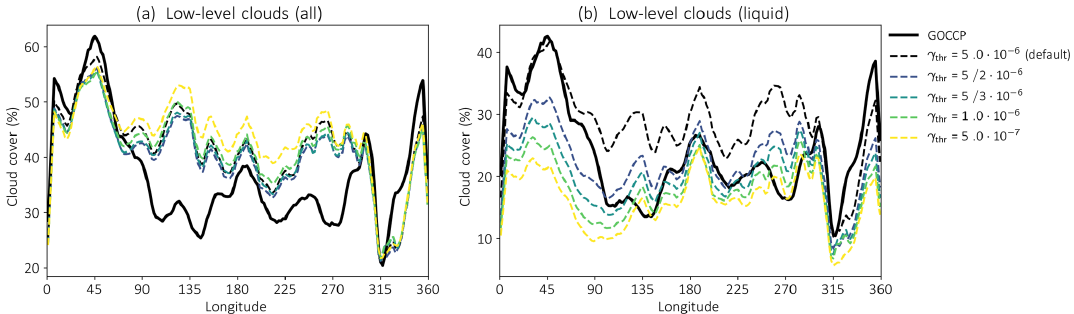
Figure 4. Meridional mean (60 to 82 ◦ N) low-level (a) and low-level liquid cloud cover (b) for different settings of γ thr (unit of γ thr is kgm − 3